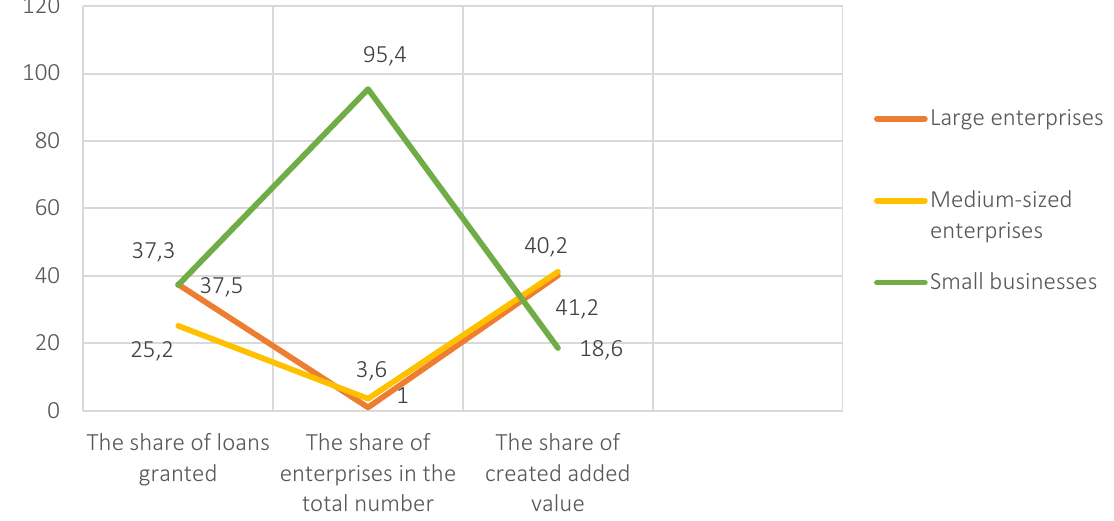
Figure 4. Indicators of shares of large, medium and small enterprises in creating value added and obtaining bank loans in Ukraine in 2017,